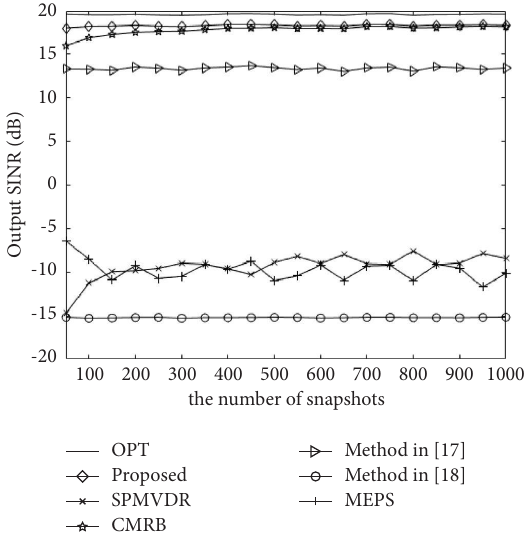
Figure 7: Output SINR versus the number of snapshots with the steering vector random